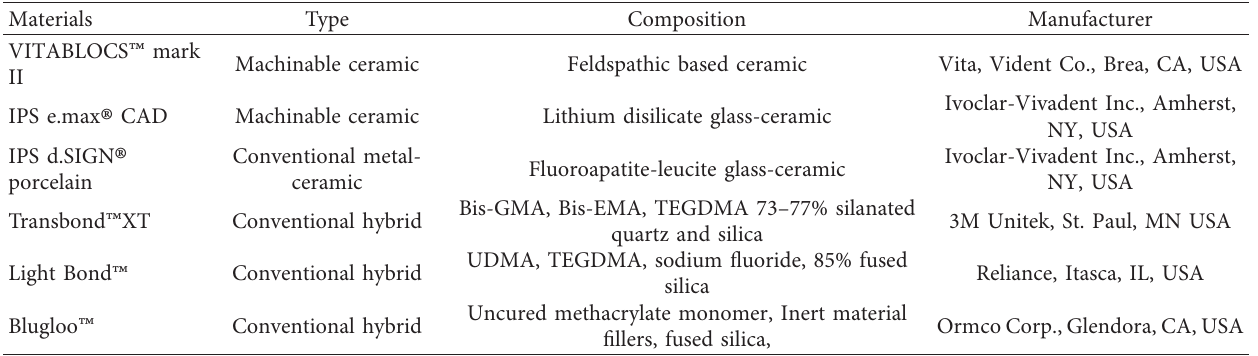
Table 1: List of dental ceramic and resin adhesive: type, composition, and